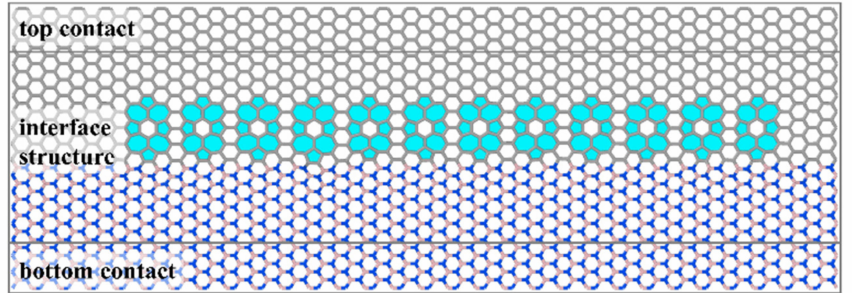
Figure 4. The basic structure of graphene/h-BN in-plane heterogeneous interface with twelve f5f7 double- vacancy defects according to the computational requirements of the phonon transmission